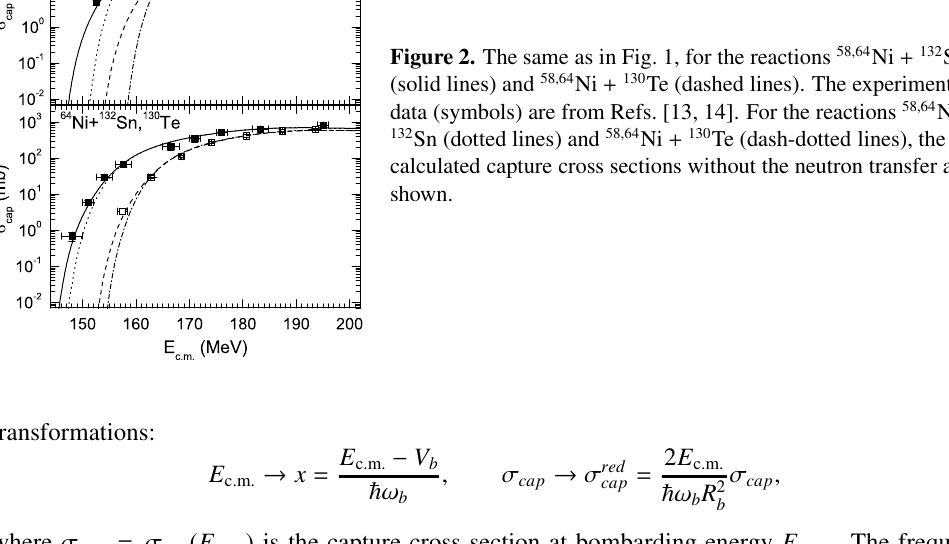
Figure 2. The same as in Fig. 1, for the reactions 58 , 64 Ni + 132 Sn (solid lines) and 58 , 64 Ni + 130 Te (dashed lines). The experimental data (symbols) are from Refs. [13, 14]. For the reactions 58 , 64 Ni + 132 Sn (dotted lines) and 58 , 64 Ni + 130 Te (dash-dotted lines), the calculated capture cross sections without the neutron transfer are